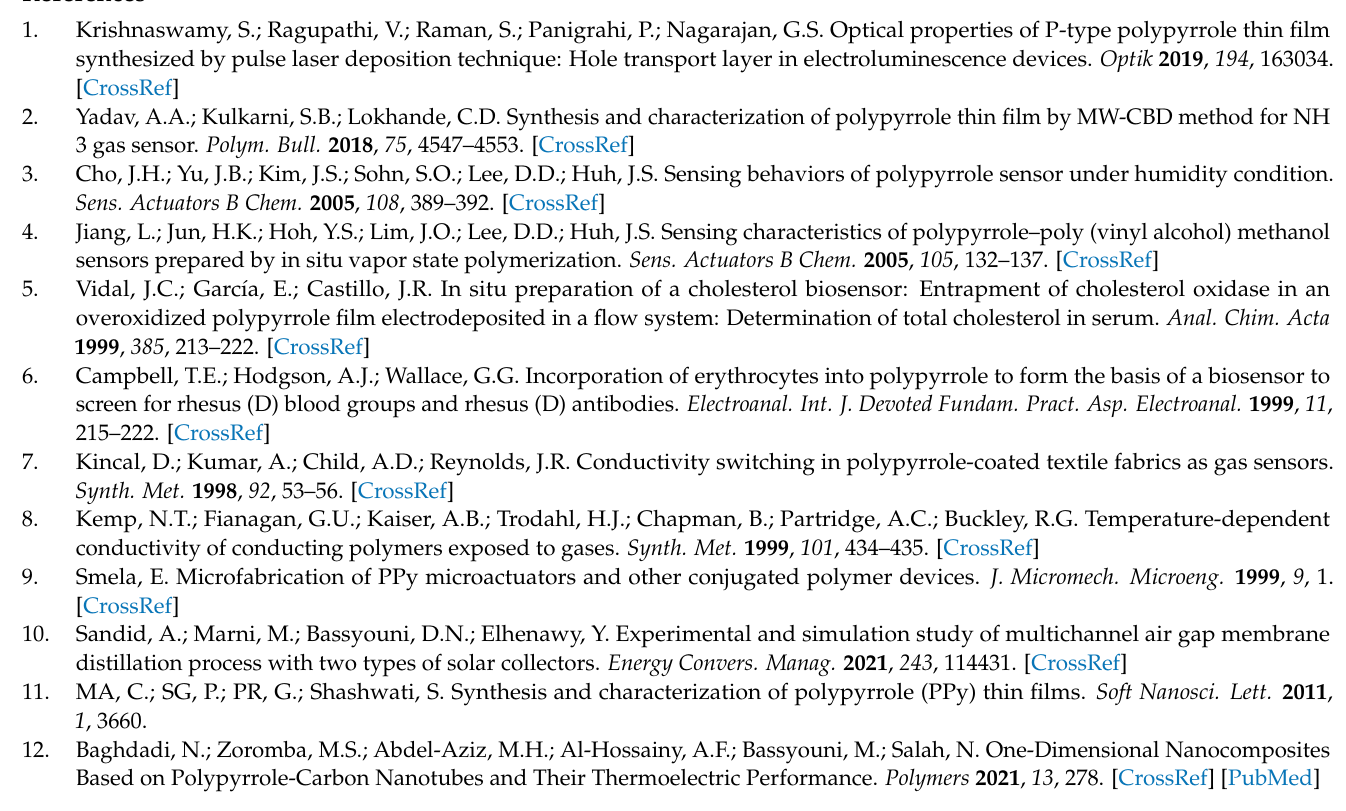
Figure S5: I–V characteristics curves and Log J for (a) Au/[PPy]/n-Si/Al; (b) Au/[PPy/MWCNTs]-1 composites/n-Si/Al; (c) Au/[PPy/MWCNTs]-2 composites/n-Si/Al and (d) Au/[PPy/MWCNTs]-3 composites/n-Si/Al heterojunction